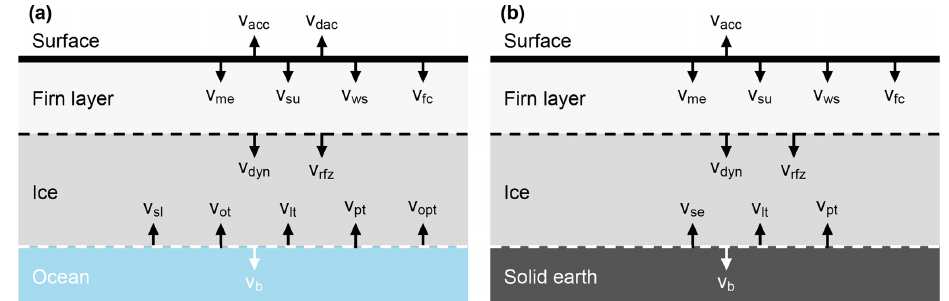
Figure 3. Representation of processes contributing to surface elevation changes for (a) ice shelves and (b) grounded ice. Modified from Ligtenberg et al. (2011) and Zwally and Li (2002). Processes represented in schematic: accumulation ( v acc ), dynamic atmosphere ( v dac ), snowmelt ( v me ), sublimation ( v su ), wind scour ( v ws ), firn compaction ( v fc ), ice dynamics ( v dyn ), meltwater refreeze and retainment ( v rfz ),